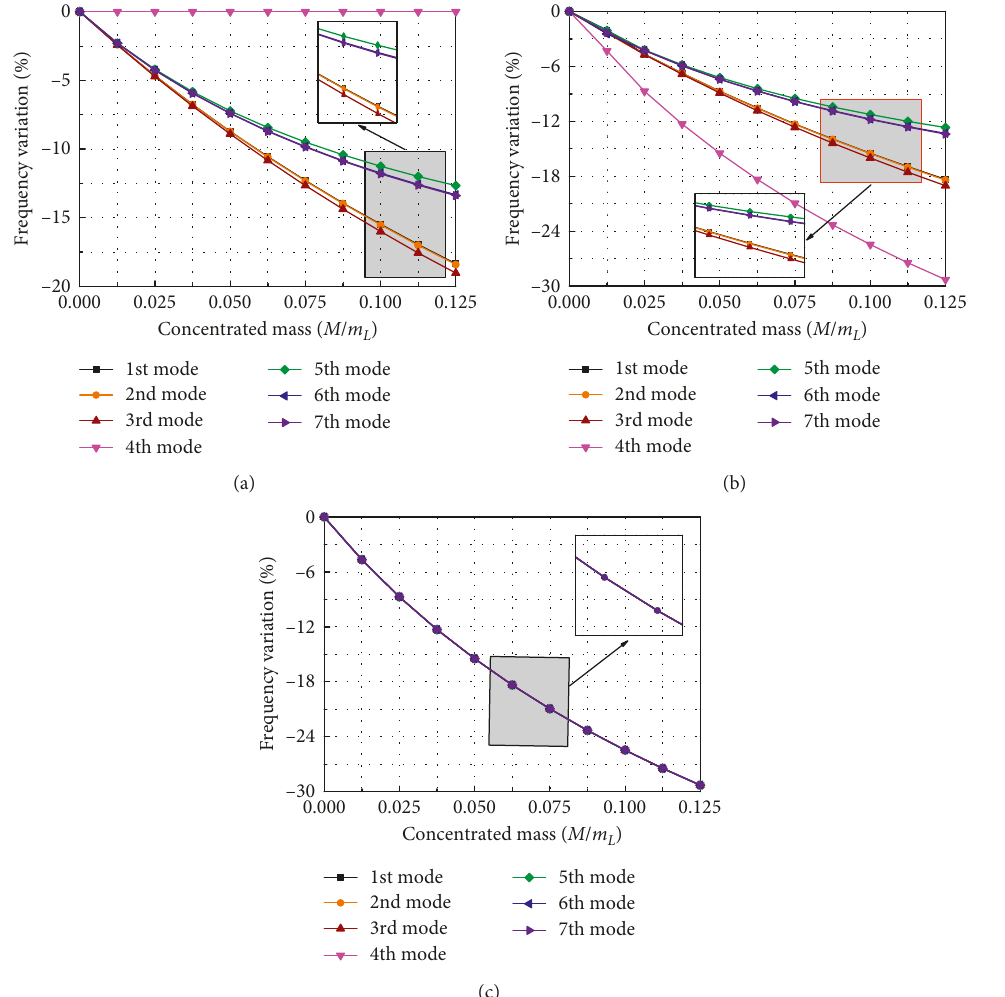
Figure 6: Frequency variations of the simplified model with several additional concentrated masses: (a) 3 concentrated masses on position 2, 4, and 6; (b) 4 concentrated masses on position 1, 3, 5, and 7; and (c) 7 concentrated masses on every